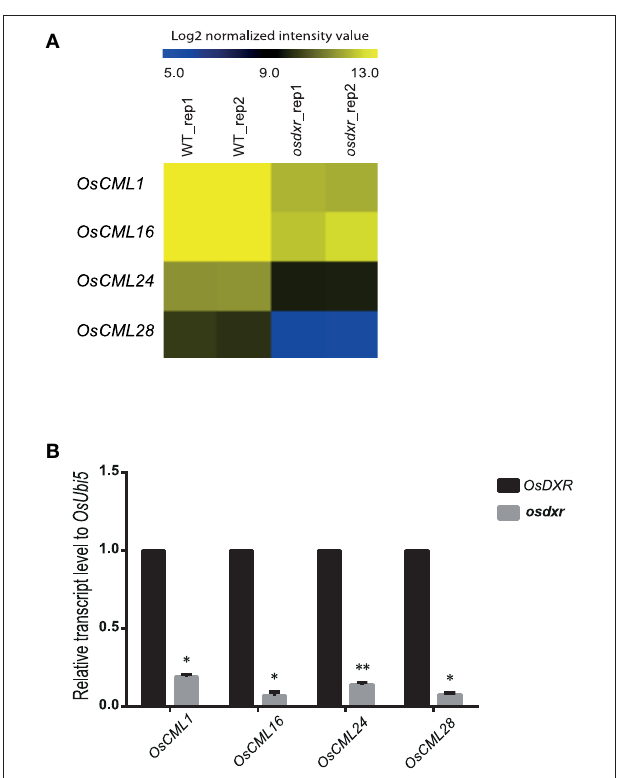
FIGURE 5 | Heatmap for light- or dark-inducible expression of OsMLO genes in wild-type (WT/DXR) rice and osdxr mutant. (A) Analysis of 3 genes using Agilent 60K microarray data for osdxr mutant. (B) Validation of expression of OsMLO1 , OsMLO3 , and OsMLO8 in WT (DXR) and osdxr mutant. Transcripts of OsDxr was absent in knockout plant. ** p < 0.01; *0.01 < p < 0.05.